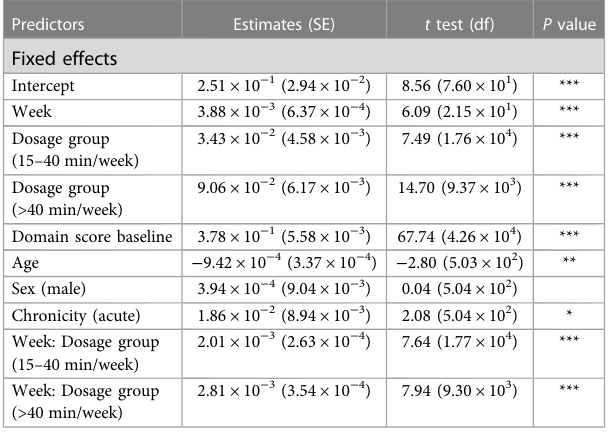
TABLE 2 Final linear mixed-effects model results summary of consistent cohort ( fi xed